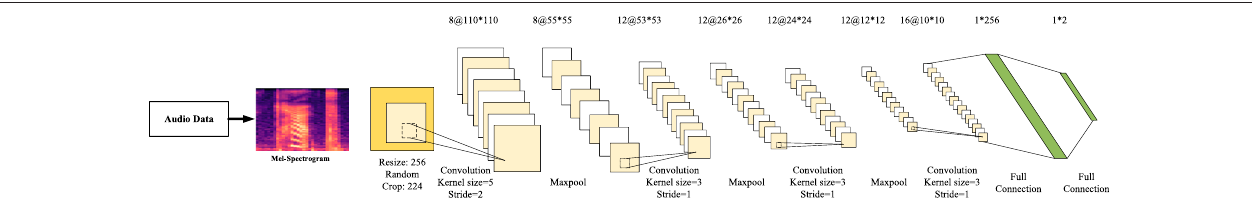
FIGURE 4 | The Architecture of the Mel-spectrogram and CNN model.